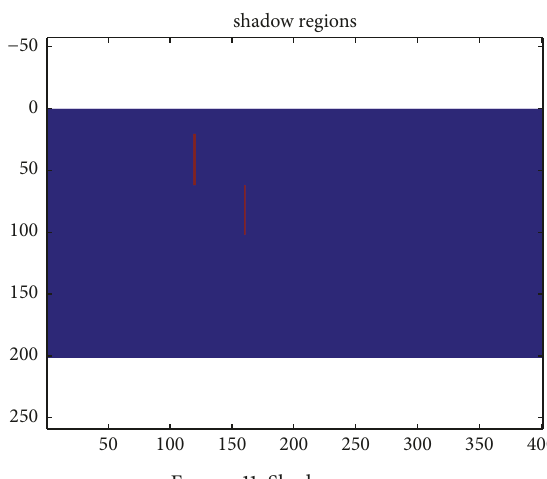
Figure 11: Shadow